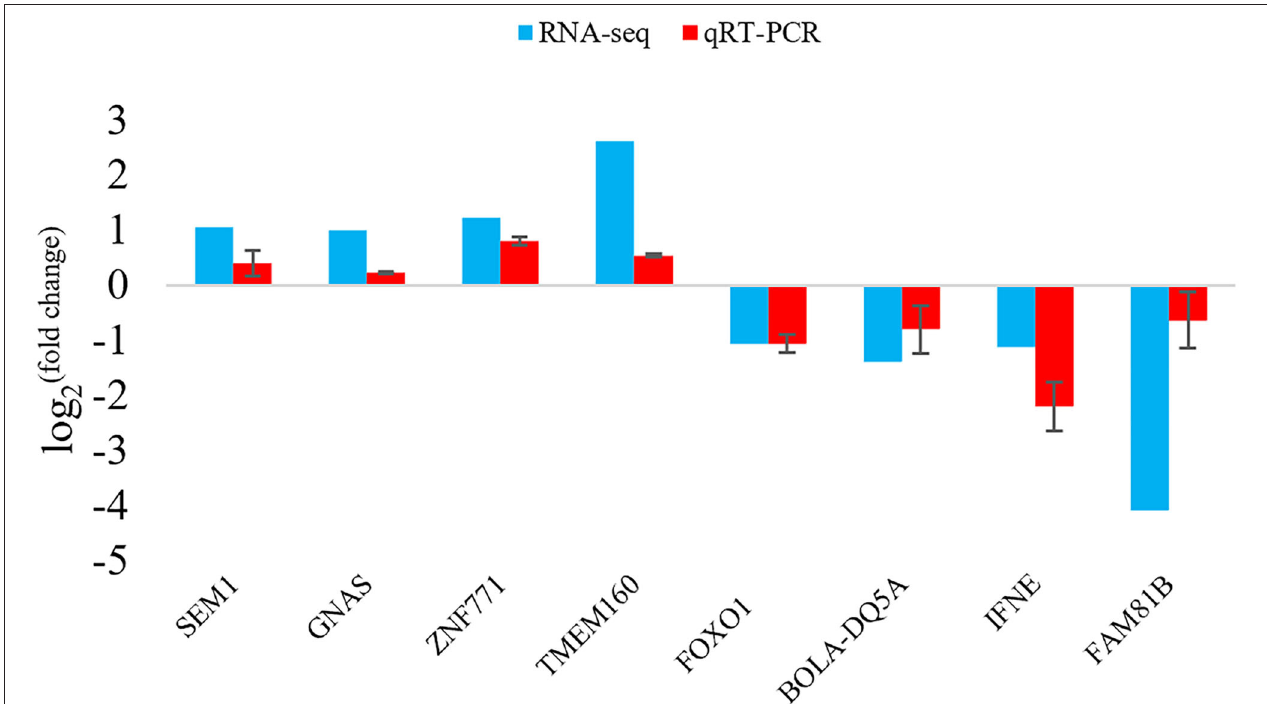
FIGURE 5 | qRT-PCR validation of